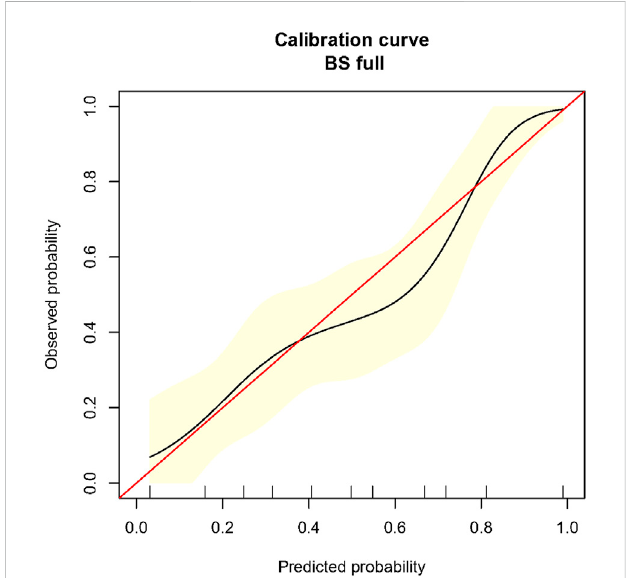
FIGURE 4 Decision curve analysis comparing the clinical utility between the two models in a propensity-score-matched population. Caption: Model 1 included BCT angle, aortic tortuosity, and aortic arch diameter.